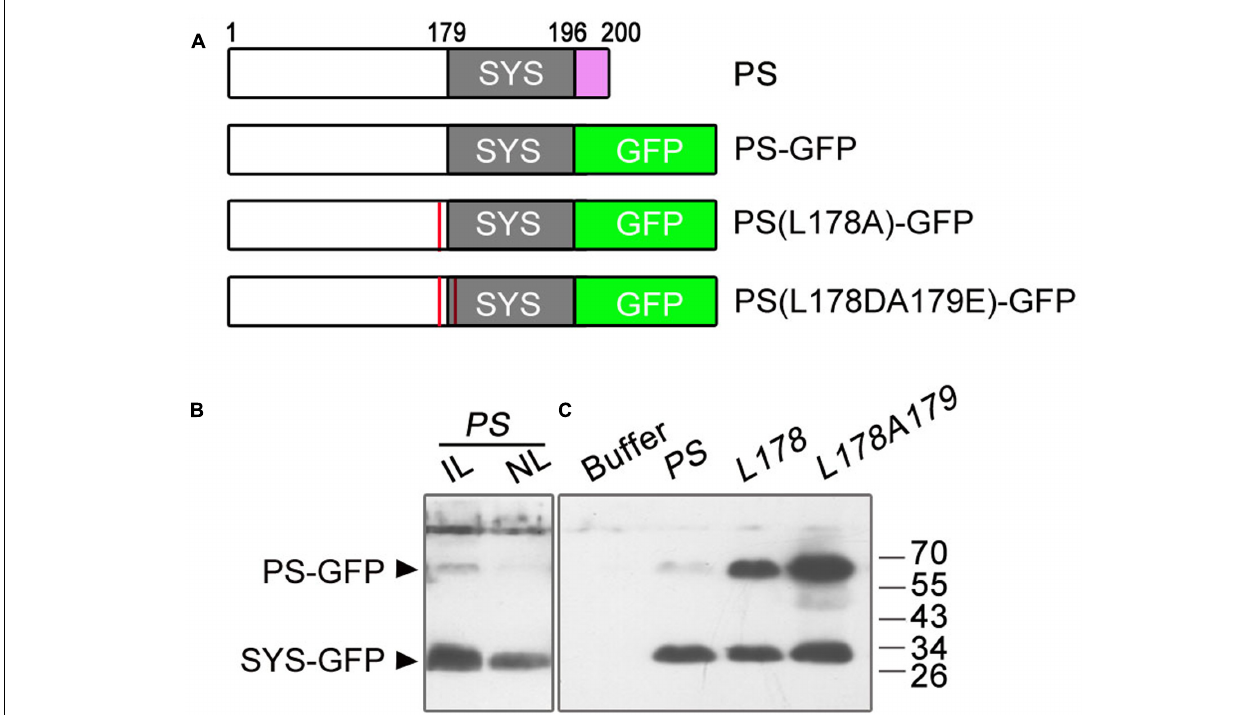
FIGURE 5 | Immunoblot analysis of GFP fusion proteins in infiltrated and non-infiltrated leaves of tomato. (A) Summary of the PS constructs tested for immunoblot analysis of GFP fusion proteins. The wild-type PS consists of 200 amino acids. The numbers above the boxes denote the amino acid number in the wild-type sequence. The gray boxes represent the location of SYS peptide in the various PS proteins. Substitution of the last four amino acids (NNKL, purple box) of the PS protein with the GFP sequence (green box) was performed to produce the PS-GFP fusion protein. The red lines in PS(L178A)-GFP and PS(L178DA179E)-GFP denote replacement of Ala for Leu178 proximate to the N-terminus of the SYS domain and substitution for Leu178 and Ala179 (the first residue of the SYS domain) by Asp and Glu in PS protein, respectively. (B) Immunoblots with GFP antibodies in leaves infiltrated and non-infiltrated leaves of tomato. In a 1-month-old plant, lower leaves were infiltrated with Agrobacteria harboring pro35S::PS-GFP (PS) plasmid. The infiltrated and non-infiltrated leaves were harvested at 4 days post-infiltration and the protein levels of PS were analyzed by Immunoblot, respectively. IL, infiltrated leaves; NL, non-infiltrated leaves. (C) Immunoblots with GFP antibodies in leaves infiltrated with suspension buffer (see Materials and Methods), pro35S::PS-GFP ( PS ) or PS mutant plasmids [ L178 , pro35S::PS(L178A)-GFP ; L178A179 , pro35S::PS(L178DA179E)-GFP ]. The bands of PS-GFP and SYS-GFP are